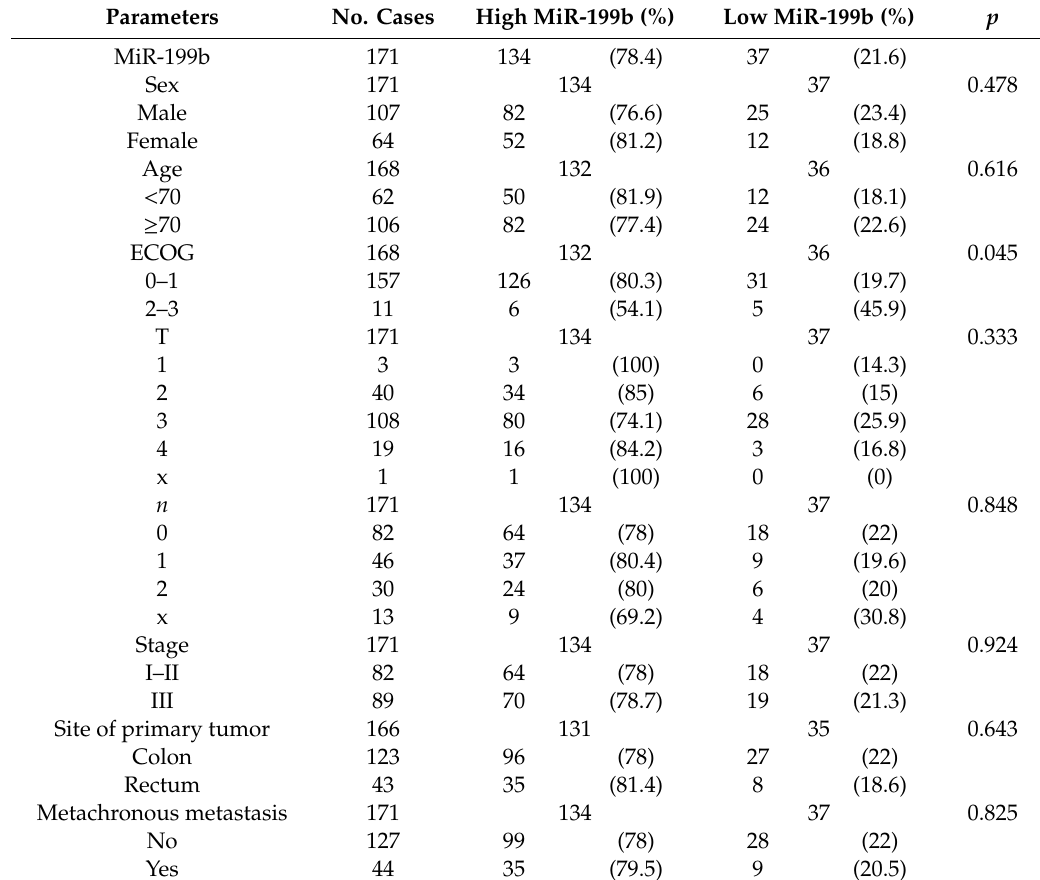
Table 1. Association between miR-199b and clinical and molecular characteristics in 171 colorectal cancer (CRC) patients with localized disease at diagnosis.